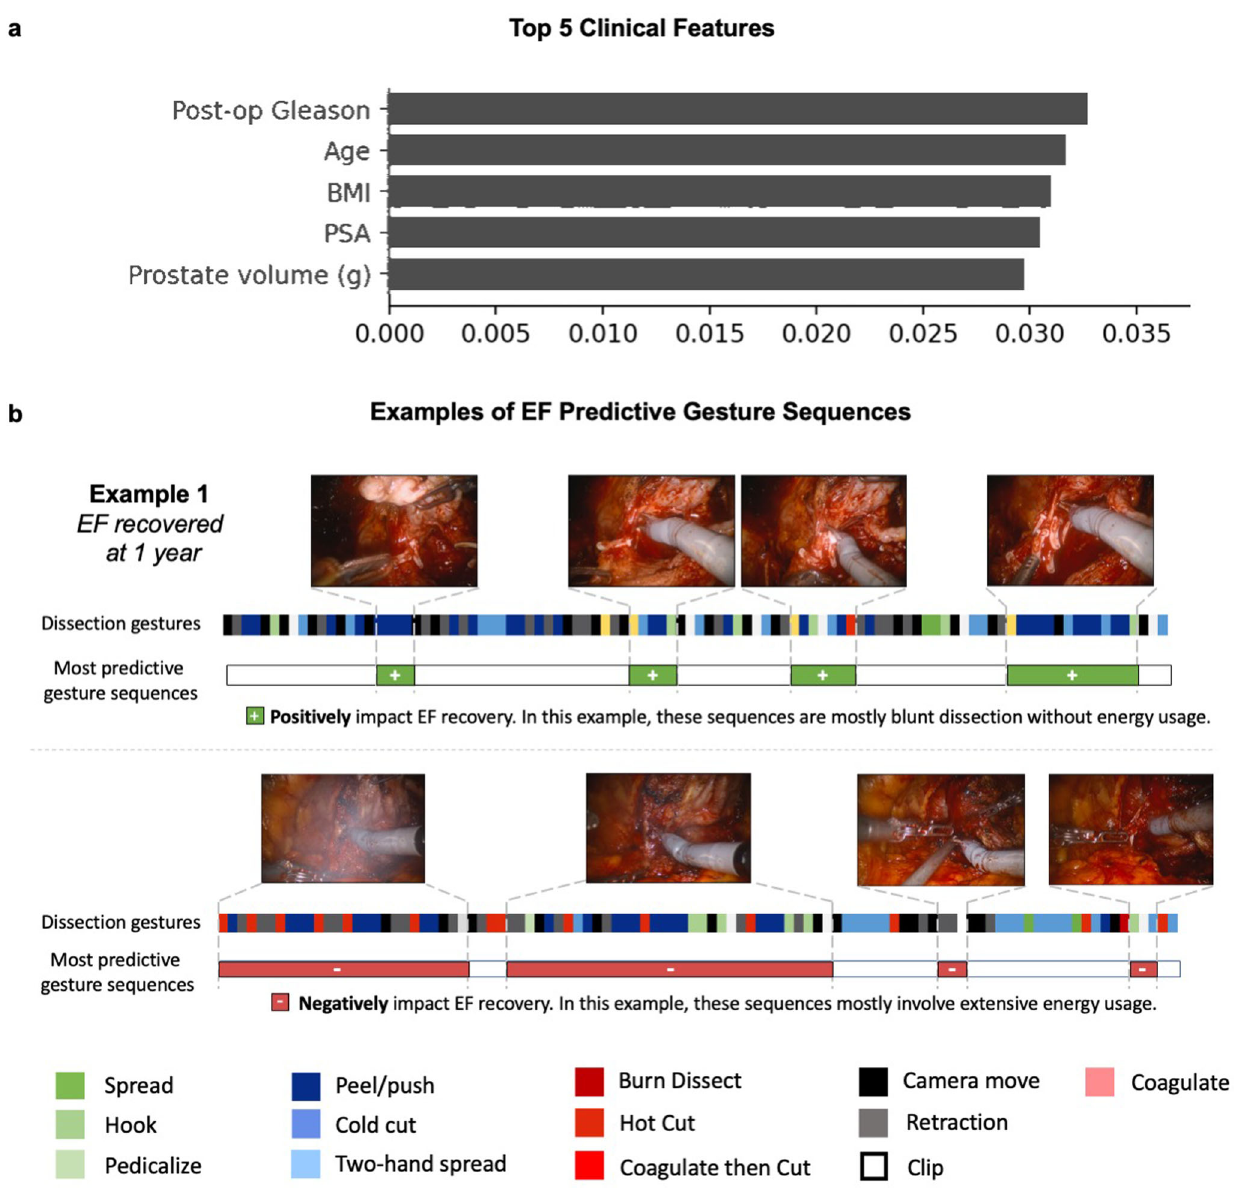
Fig. 5 Important clinical features and gesture sequences for 1-year EF prediction. a Important clinical features; b examples of important surgical gesture